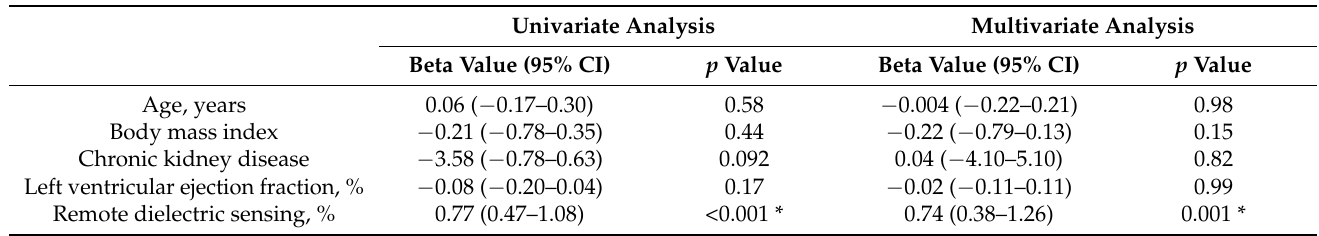
Table 2. Impact of Remote dielectric sensing values and other potential confounders on pulmonary capillary wedge pressure.